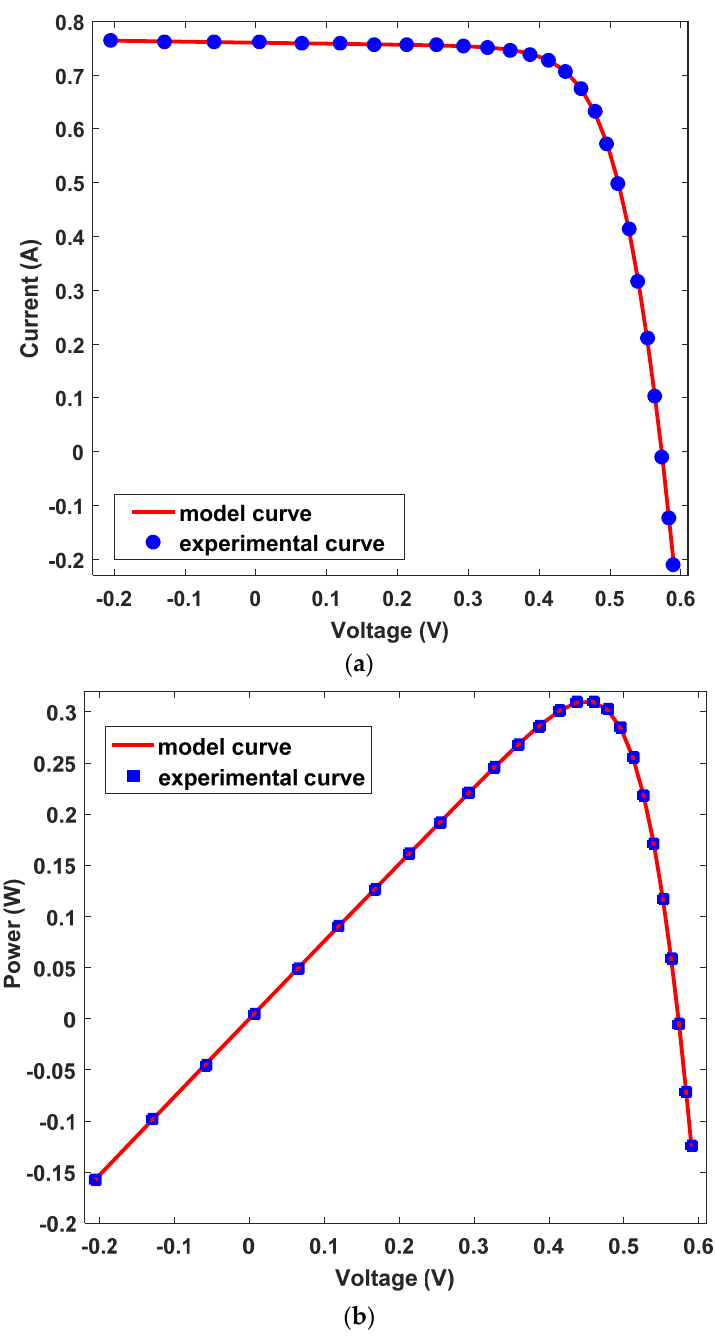
Figure 11. Comparisons between measured data and data achieved using the MECPO method for SDM ( a ) I–V characteristics and ( b ) P–V characteristics.